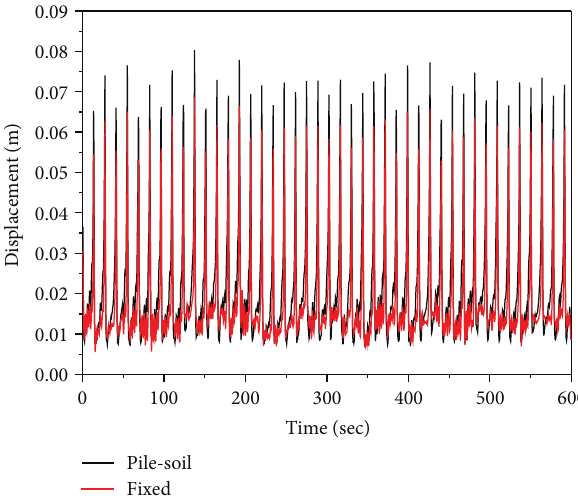
Figure 8: Comparison of displacements with regular wave at MSL.